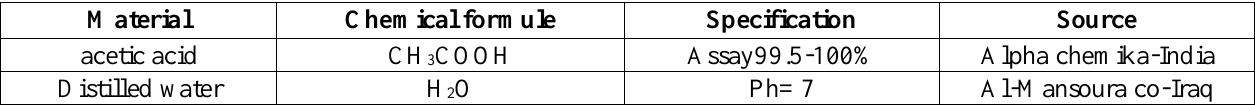
Table 1: Material used in attapulgite separation